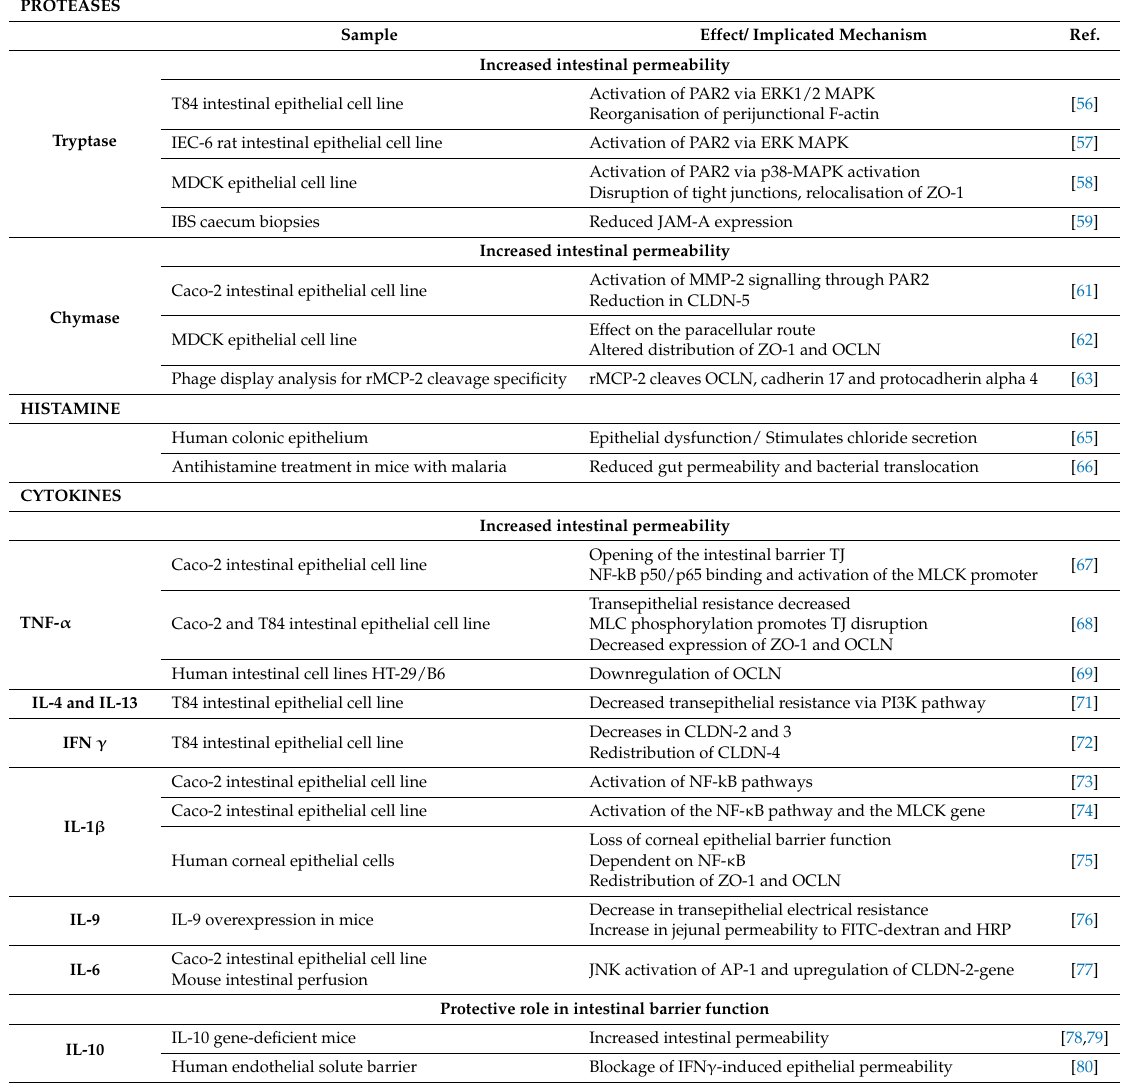
Table 2. Mast cell mediators and mechanisms associated with epithelial barrier